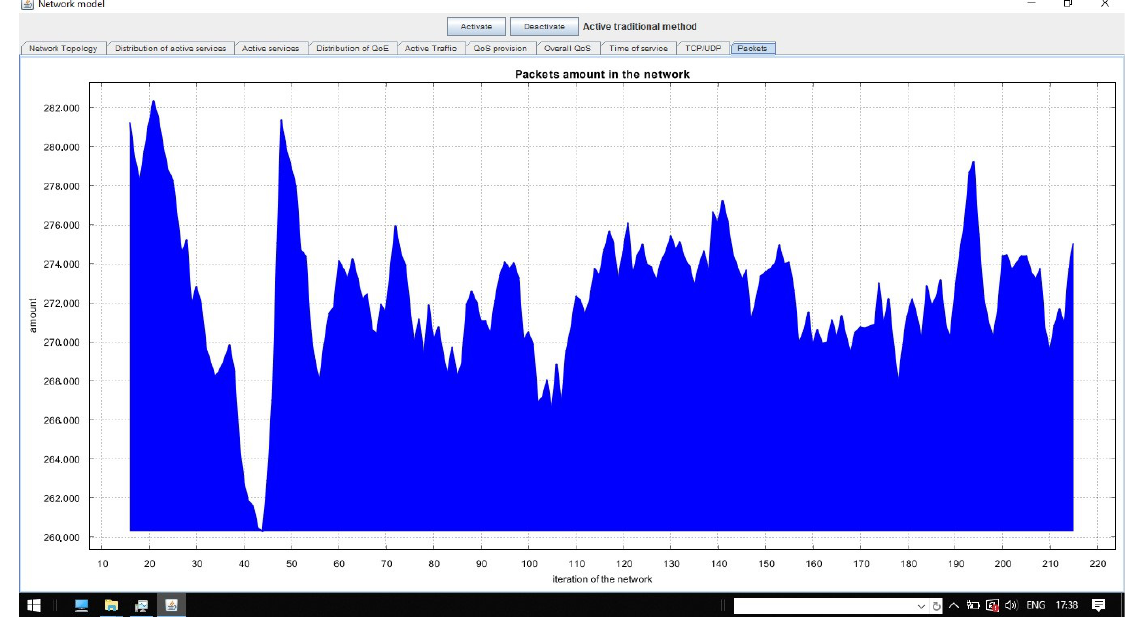
Figure 24. Graph of service